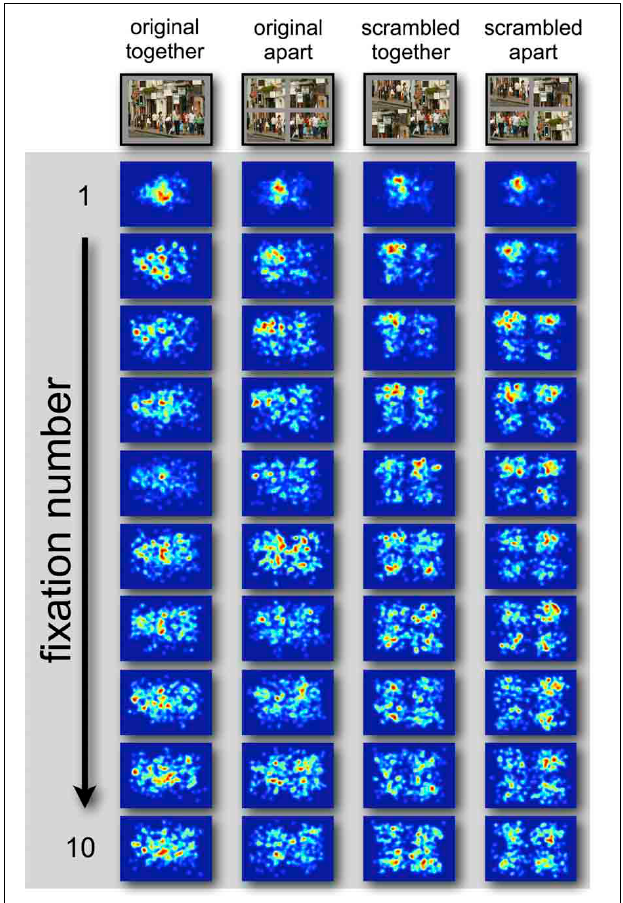
FIGURE 6 | Gaussian heat-map of the time-course fixation distribution by ordinal fixation